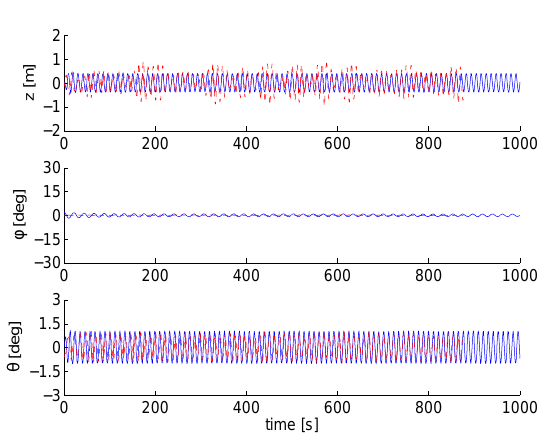
Figure 12: Exp. 1182. Exp. dashed red, sim. solid